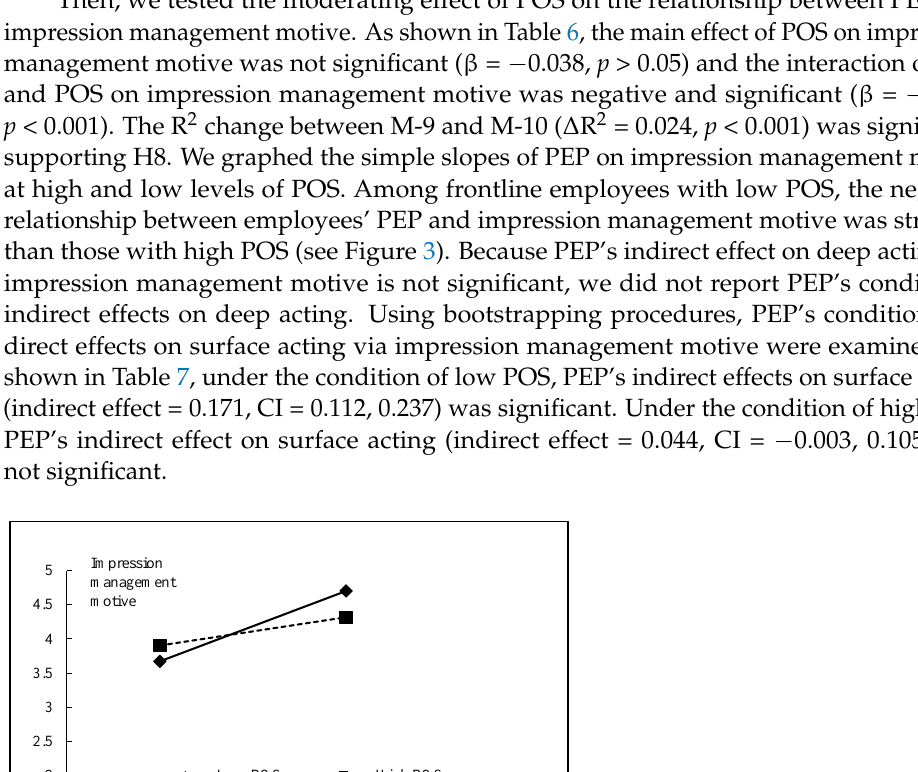
Figure 3. The moderating effect of POS on the relationship between PEP and impression manage- ment motive.